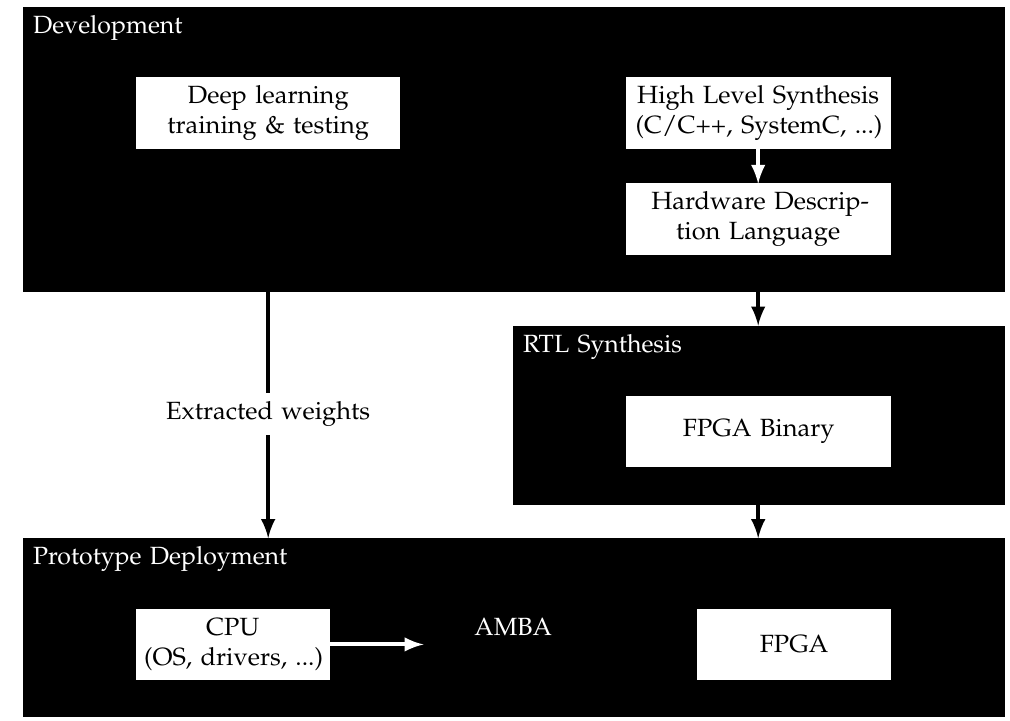
Figure 3. Methodology